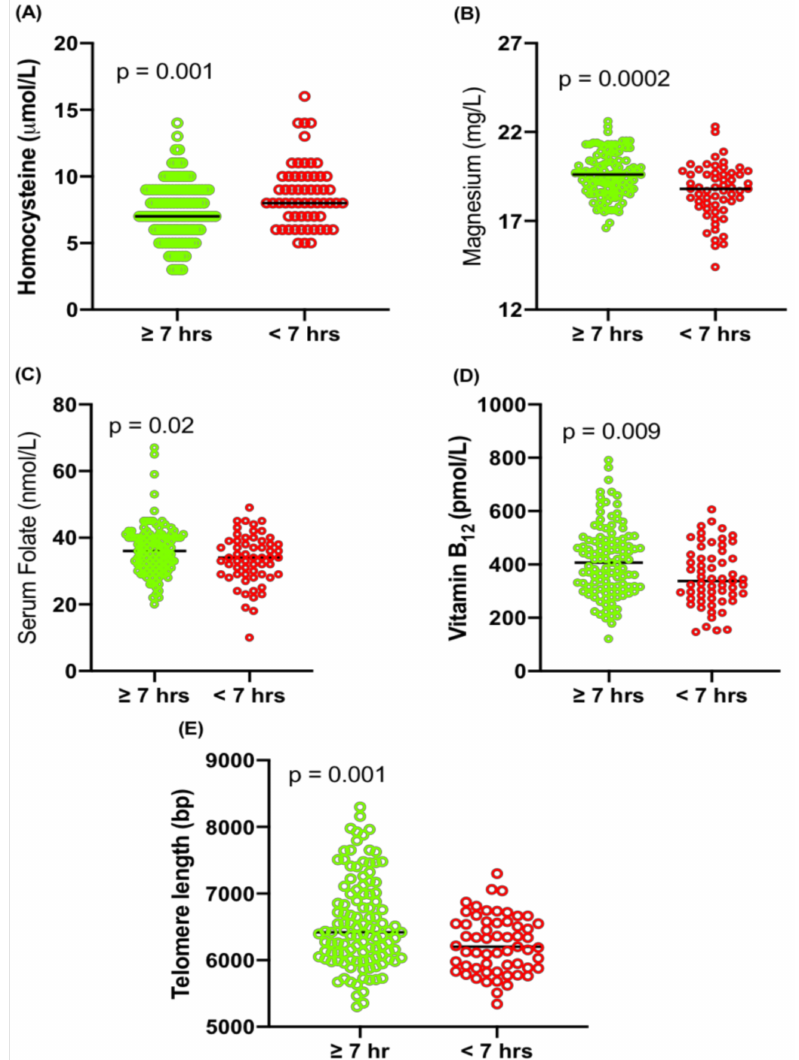
Figure 3. ( A ) Homocysteine concentration in subjects who slept ≥ 7 h (n = 113; Male 22; Female 91) and <7 h (n = 59; Male 14; Female 45); ( B ) magnesium levels in subjects who slept for ≥ 7 h and <7 h; ( C ) serum folate concentration in subjects who slept ≥ 7 h and <7 h; ( D ) vitamin B 12 concentration in subjects who slept ≥ 7 h and <7 h and ( E ) telomere length (bp) in subjects who slept for ≥ 7 h and <7